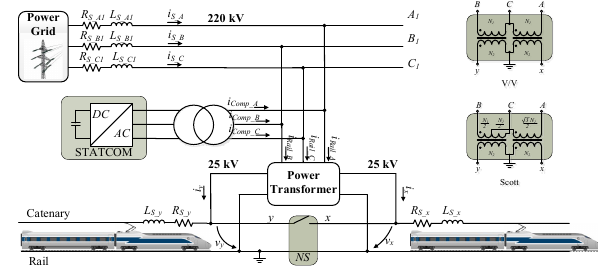
Figure 6. Electrical schematic of the STATCOM connection with the railway power system powered by V/V or Scott